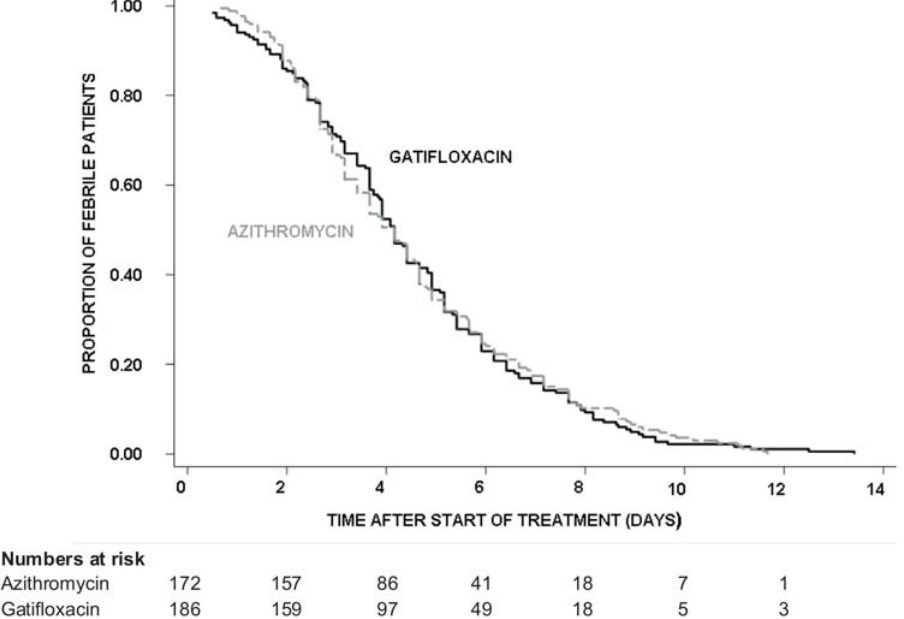
Figure 3. Proportion of all randomised patients still febrile. Kaplan-Meier survival curve showing the proportion of all randomised patients (ITT analysis) still febrile through time by treatment group.